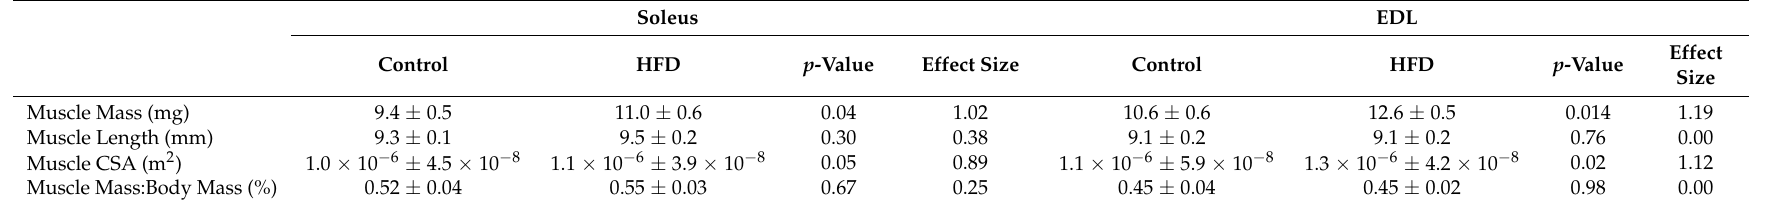
Table 2. The effects of 9 weeks of a high-fat diet (HFD) on the muscle-specific morphology for 79-week-old mice. Soleus EDL Control HFD p -Value Effect Size Control HFD p -Value